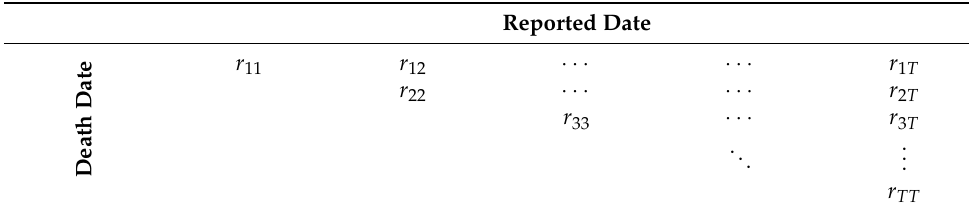
Table A1. The matrix describes how the data are structured.